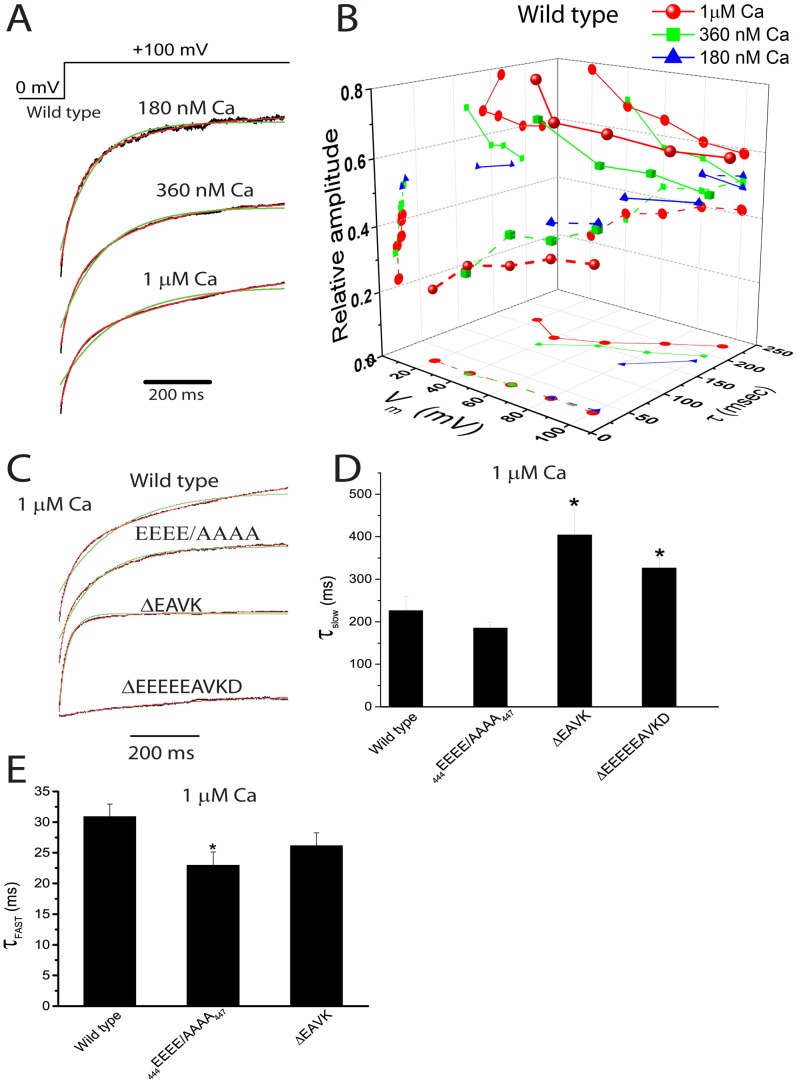
Activation kinetics of Ano1 by Ca2+ and voltage.A. Representative currents of wild type Ano1, activated by 180 µM Ca2+ at +100 mV from a holding potential of 0 mV (voltage protocol shown above). The currents were fitted to single exponentials (superimposed in green lines) and to two exponentials (superimposed in red lines). B. The relationship of the fast (τfast) (dash lines) and slow (τslow) (solid lines) components of the activation time constant of wild type Ano1 activated by 180 nM (blue triangle), 360 nM (green square), and 1 µM (red circle) Ca2+ at voltages between +20 mV to +100 mV from a holding potential of 0 mV (n = 4–6 cells). C. Representative currents of wild type, 444EEEE/AAAA447, ΔEAVK, and Δ444EEEEEAVKD452 activated by 1 µM Ca2+ at +100 mV from a holding potential of 0 mV. The currents were fitted to single exponentials (superimpose in green lines) and to two exponentials (superimposed in red lines). D.E. The time constant of the slow (D) and fast (E) components of wild type, 444EEEE/AAAA447, ΔEAVK, and Δ444EEEEEAVKD452 activated by 1 µM Ca2+ at +100 mV from a holding potential of 0 mV. n = 4–8 cells; *p<0.05 vs wild type.